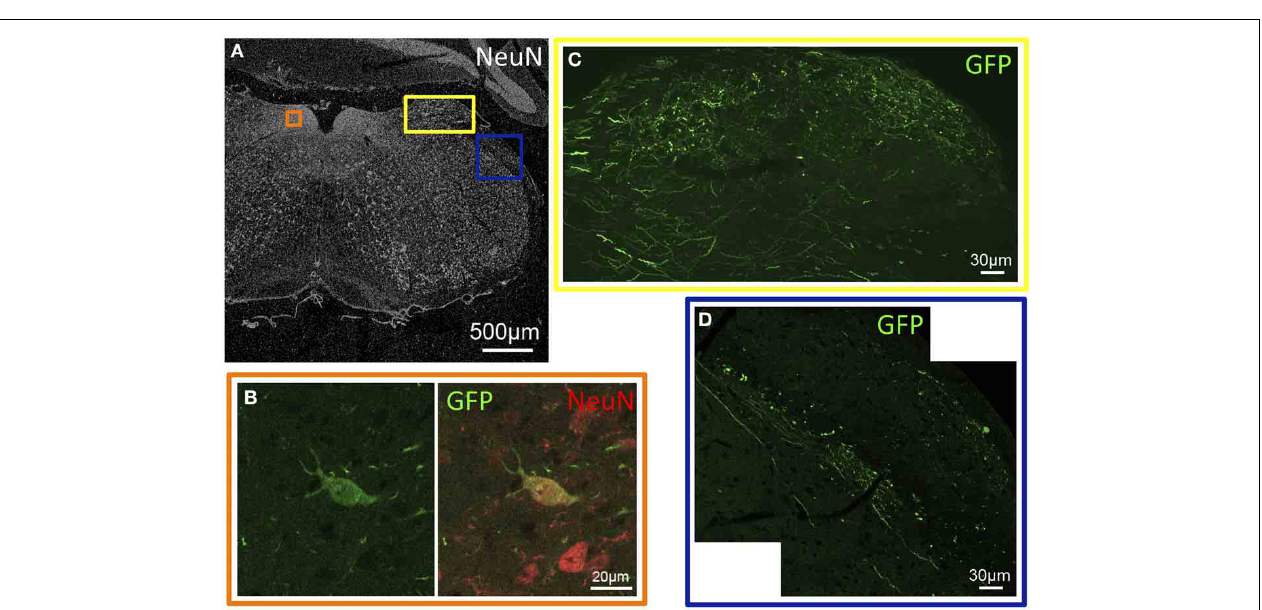
FIGURE 2 | GFP-ir in sensory nuclei of the medulla. (A) Low-magnification image showing the pattern of NeuN-ir in this tissue section (approximately − 6.8mm Bregma). Colored inset boxes show the locations of the images in